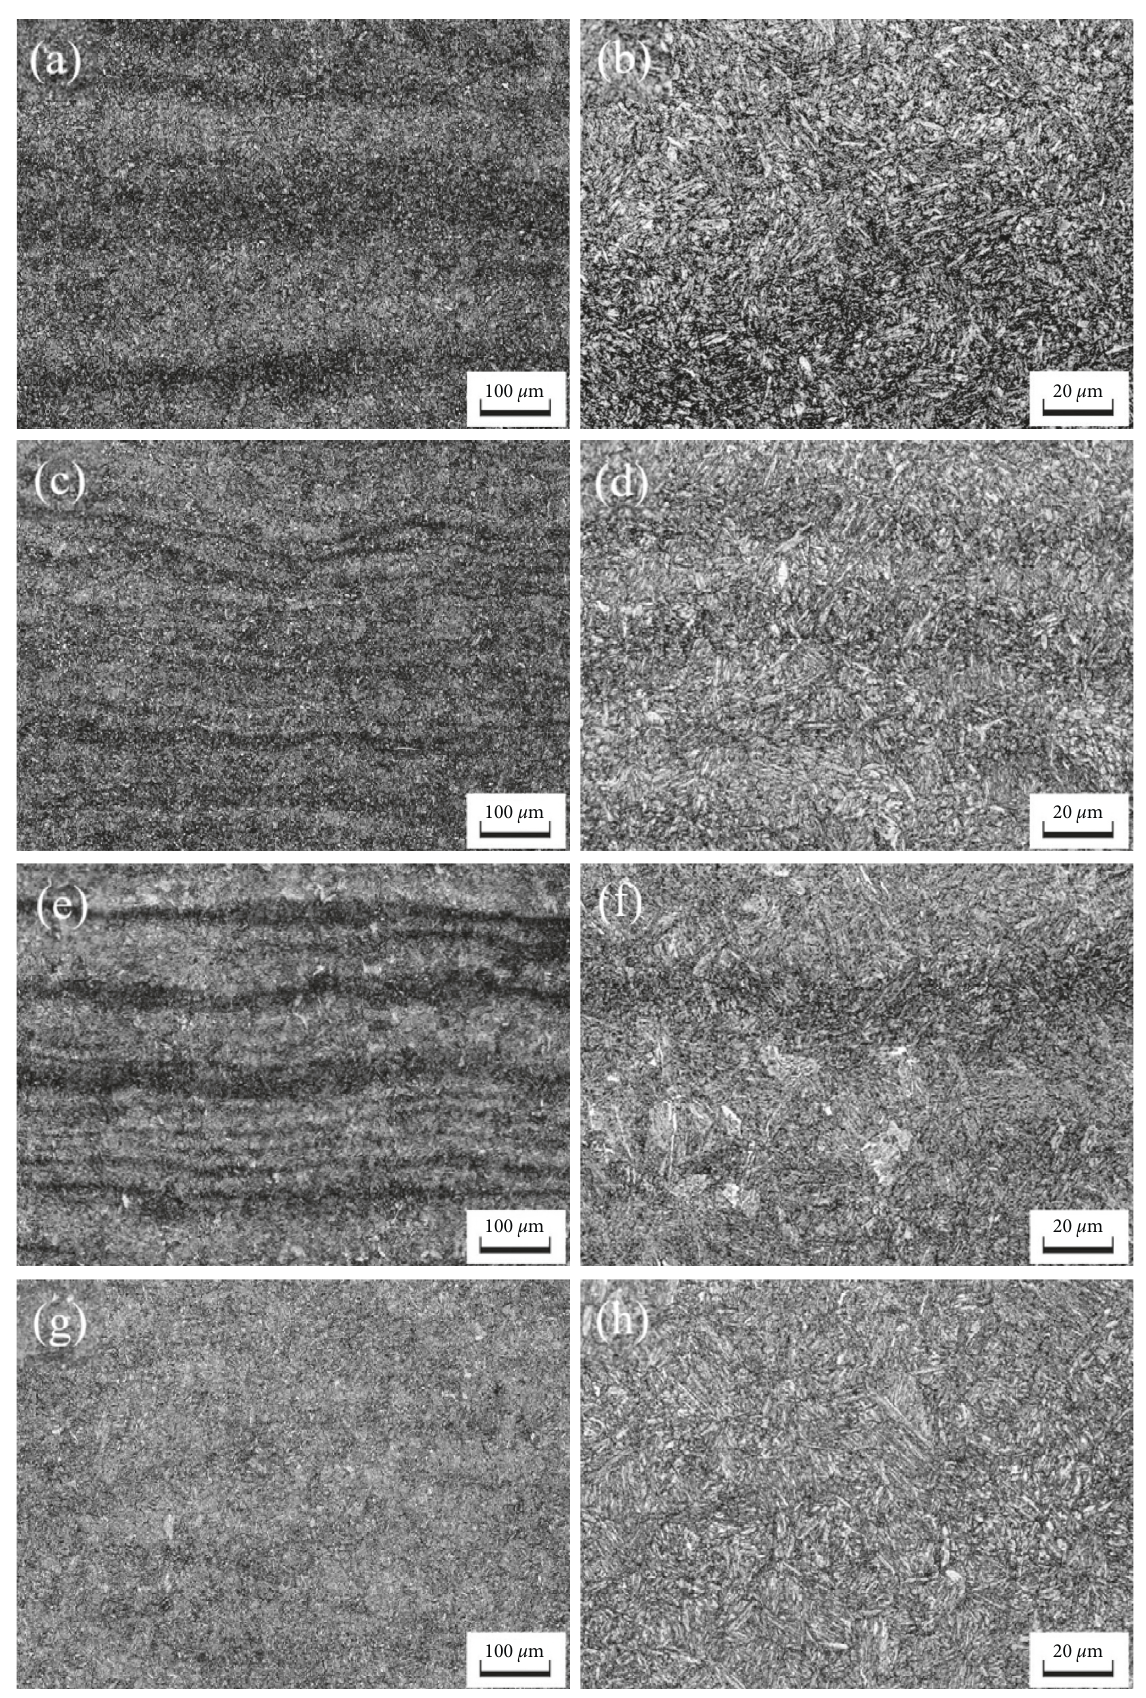
Figure 9: Microstructure comparison. (a) Microstructure of X -2. (b) Microstructure of X -2. (c) Microstructure of X -4. (d) Microstructure of X -4. (e) Microstructure of Y -2. (f) Microstructure of Y -2. (g) Microstructure of Y -4. (h) Microstructure of Y